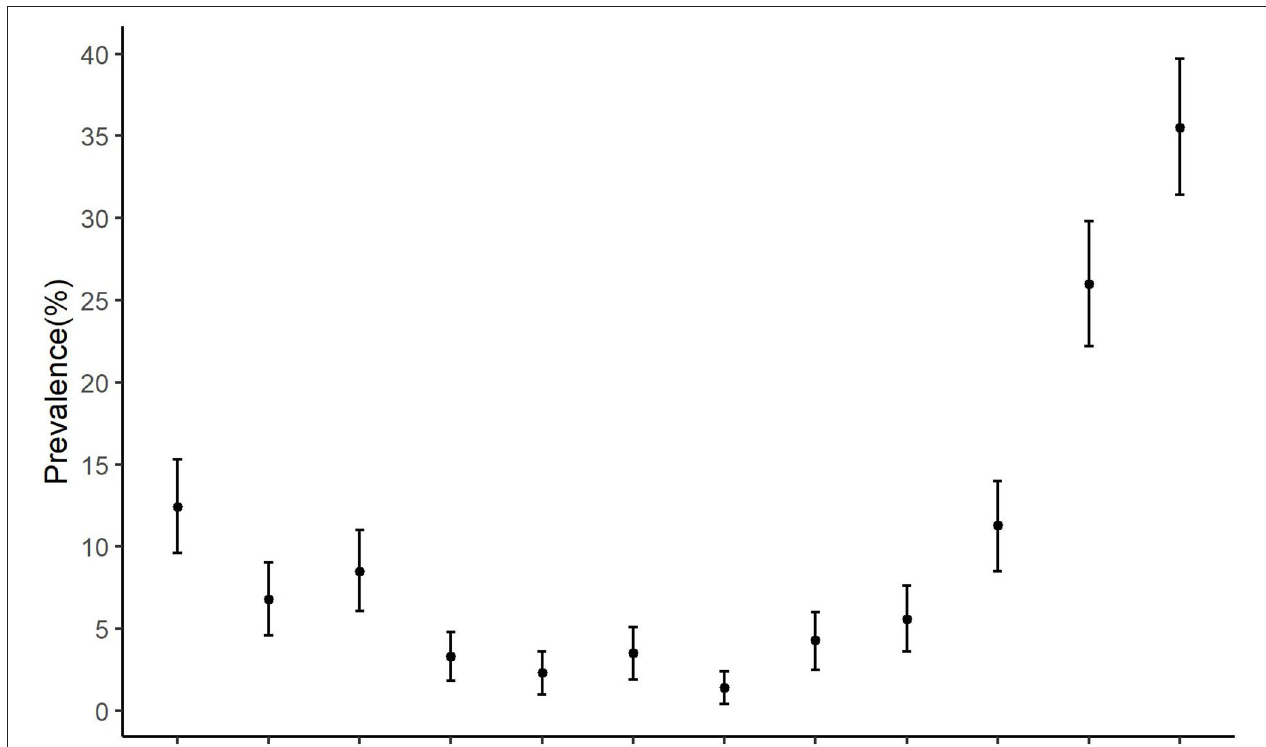
FIGURE 2 | The prevalence of anal human papillomavirus (HPV) types among HIV-negative MSM. MSM, men who have sex with men; HPV, human papillomavirus; HIV, human immunodeficiency virus; Bar, 95% CI of prevalence; 9v-HPV, nine-valent HPV types, such as HPV6, 11, 16, 18, 31, 33, 45, 52, and 58; 4v-HPV, quadrivalent HPV types, such as HPV6, 11, 16, and 18; 2v-HPV, bivalent HPV types, such as HPV16 and